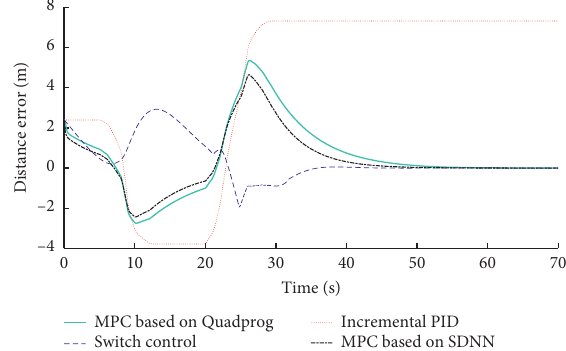
Figure 13: Distance errors of the LV and the FV of four controllers.